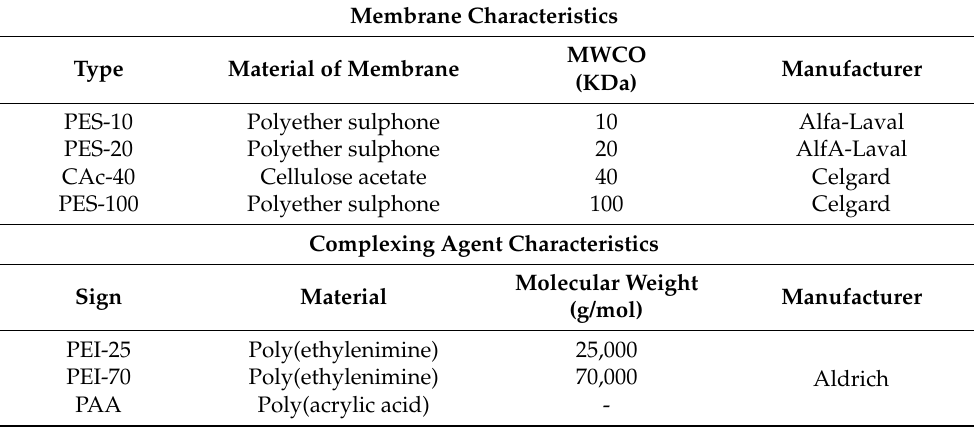
Table 3. Characteristics of the membrane and complexing agents adapted with permission from ref. [35]. Copyright 2021 Elsevier.